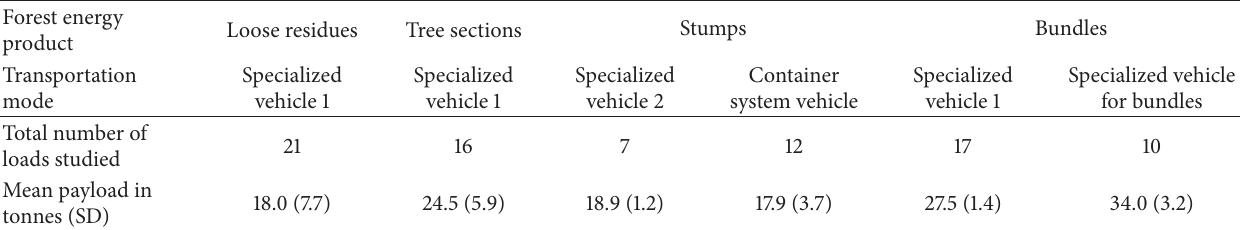
Table 1: Number of observations and mean payload for each case.